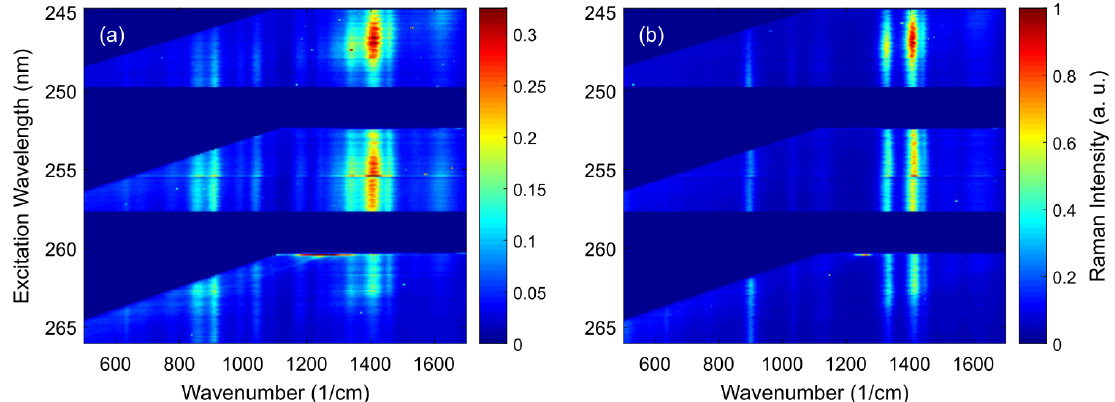
Figure 2. Excitation-emission maps (EEM) of the amino acids ( a ) proline and ( b ) glycine. Raman intensity is color-coded. Raman peaks appear as perpendicular lines. Dark blue regions in the map mark spectral ranges where no Raman signal could be measured due to lack of appropriate filters (reproduced with permission from